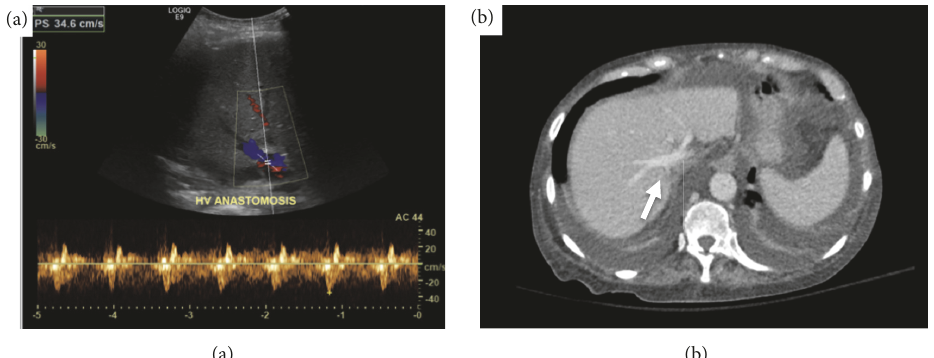
Figure 4: Posttransplant imaging reveals no sequelae of removal of retained CVC. Panel (a): liver ultrasound with Doppler showing normal hepatic venous anastomosis waveforms and velocities. Panel (b): axial contrasted CT scan showing patent, normal appearing hepatic venous anastomosis